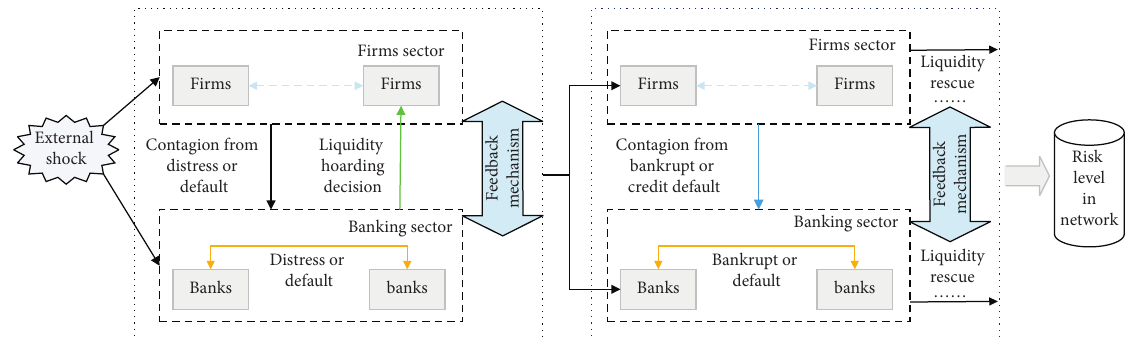
Figure 2: Diagram of systemic risk contagion mechanism in financial credit network within banks and